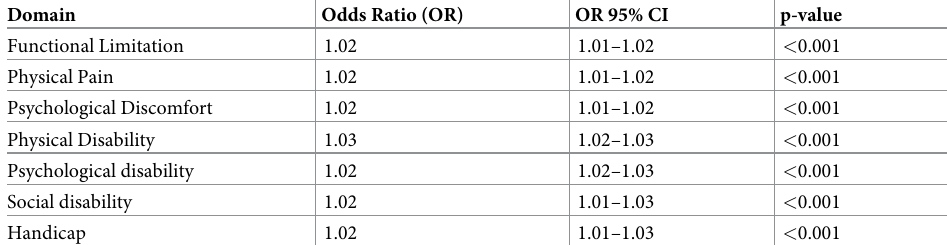
Table 4. Multiple logistic regression on the association between radiographically screened periodontitis with OHIP-14 domains (n = 10,267).